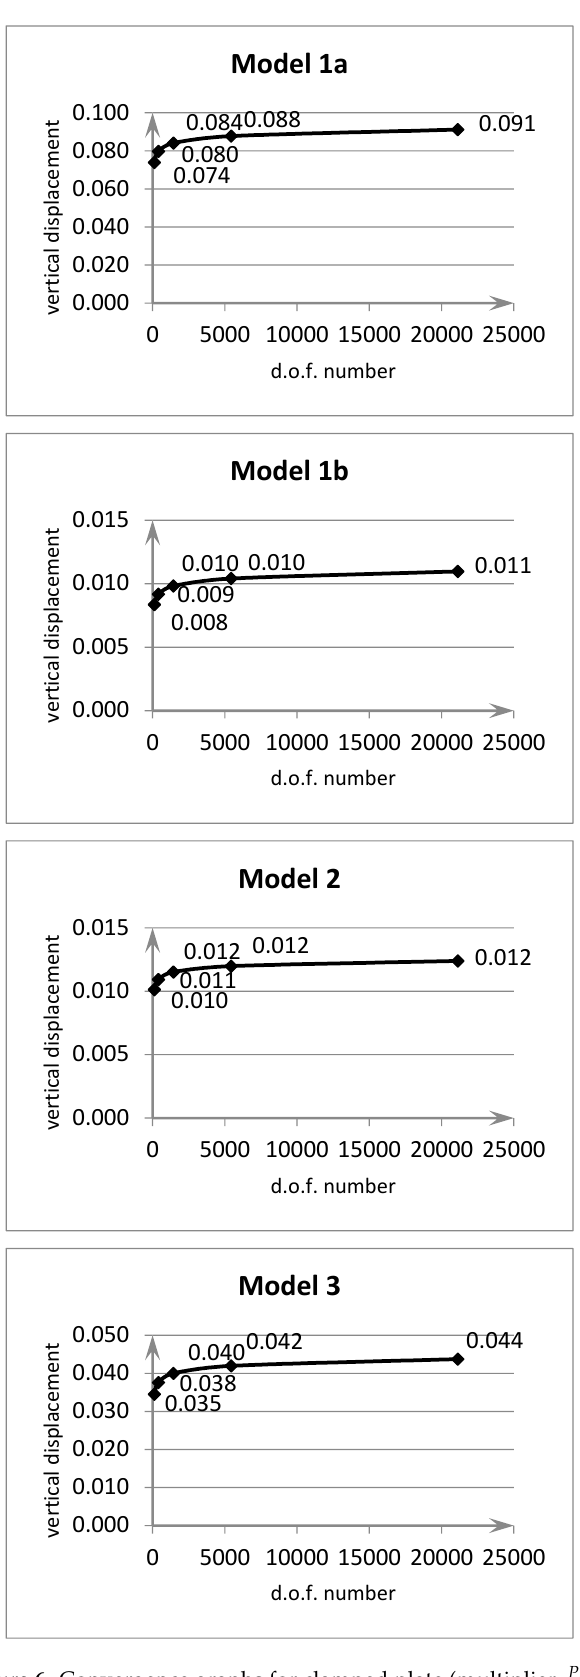
Figure 6. Convergence graphs for clamped plate (multiplier PL 2